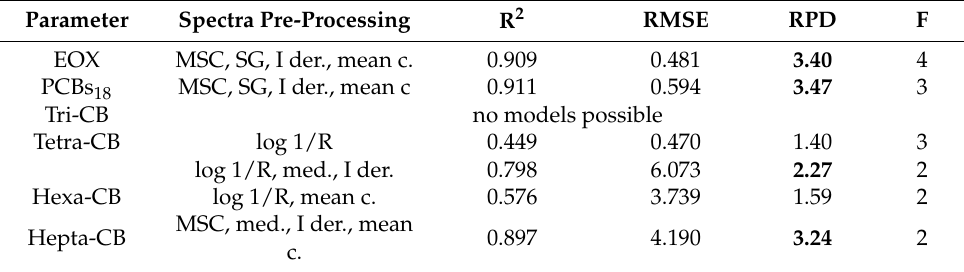
Table 5. Calibration statistics of PSLR models for PCB and EOX contents in the soil samples. Parameter Spectra